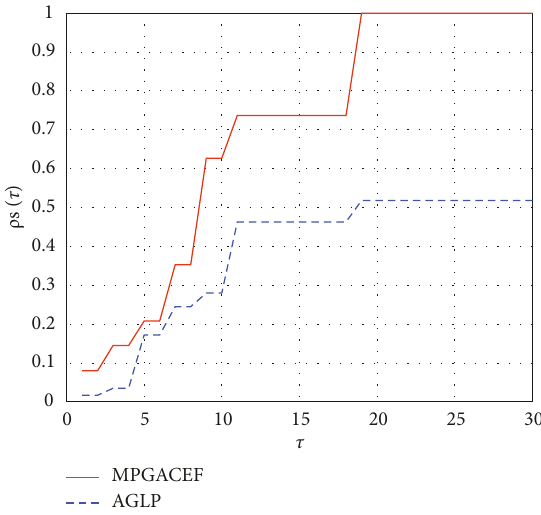
Figure 5: Performance of NIT Time for MPGACEF and AGLP under the condition of